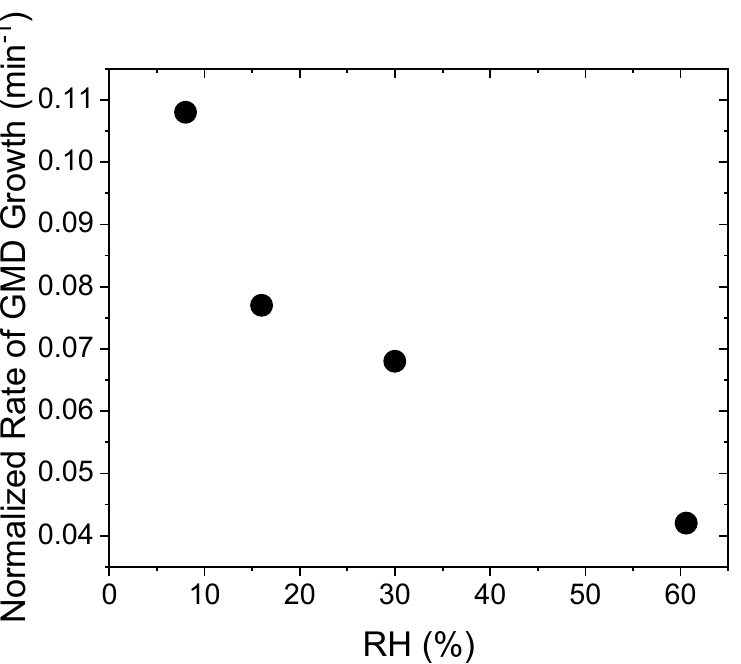
Figure 9. Normalized rate of GMD growth for 10-ppb v α -pinene aerosol as a function of RH.